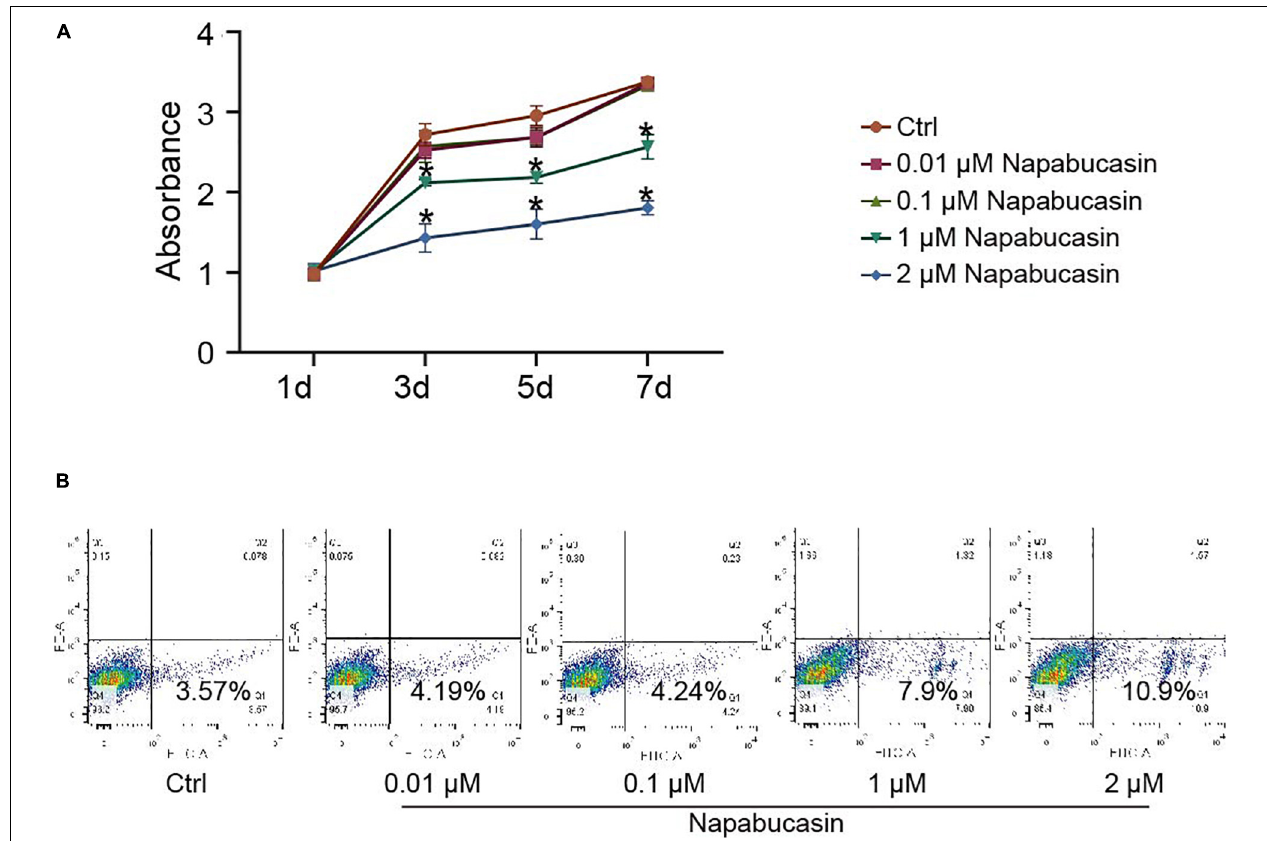
FIGURE 1 | Effects of Napabucasin on proliferation and apoptosis of BMSCs. (A) CCK8 assay of BMSCs after treatment with DMSO or with different concentrations of Napabucasin for 1, 3, 5, and 7 days. N = 5. Data are represented as means ± S.D. * P < 0.05. (B) Apoptosis assay of BMSCs treated with DMSO or with different concentrations of Napabucasin for 2